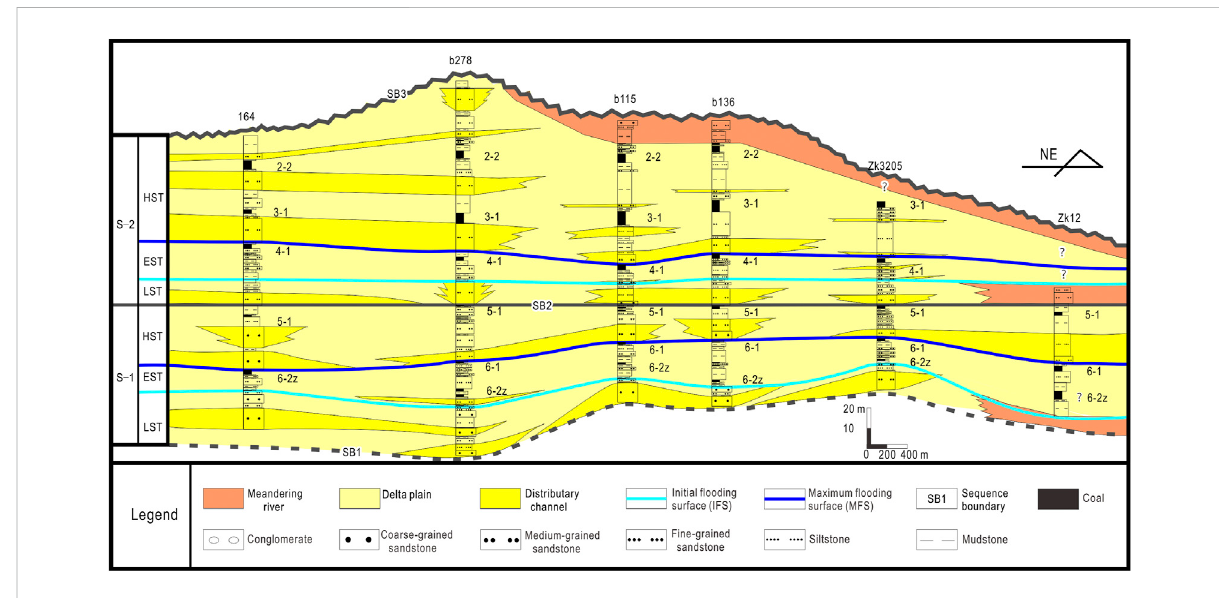
FIGURE 8 NE-SW cross-section (E-E ′ ) through the Yan ’ an Formation, showing lithofacies, interpreted depositional environments (including coal seams)